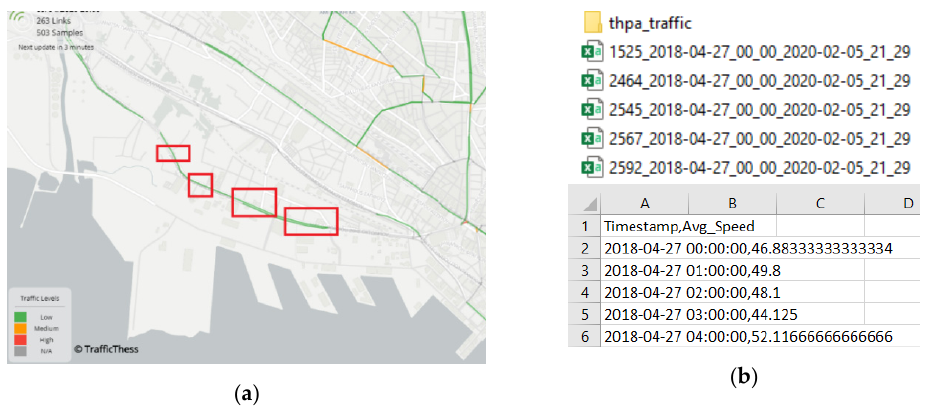
Figure 8. Tra ffi c city data origin and procedure is shown as a figure, ( a ) Selected relevant